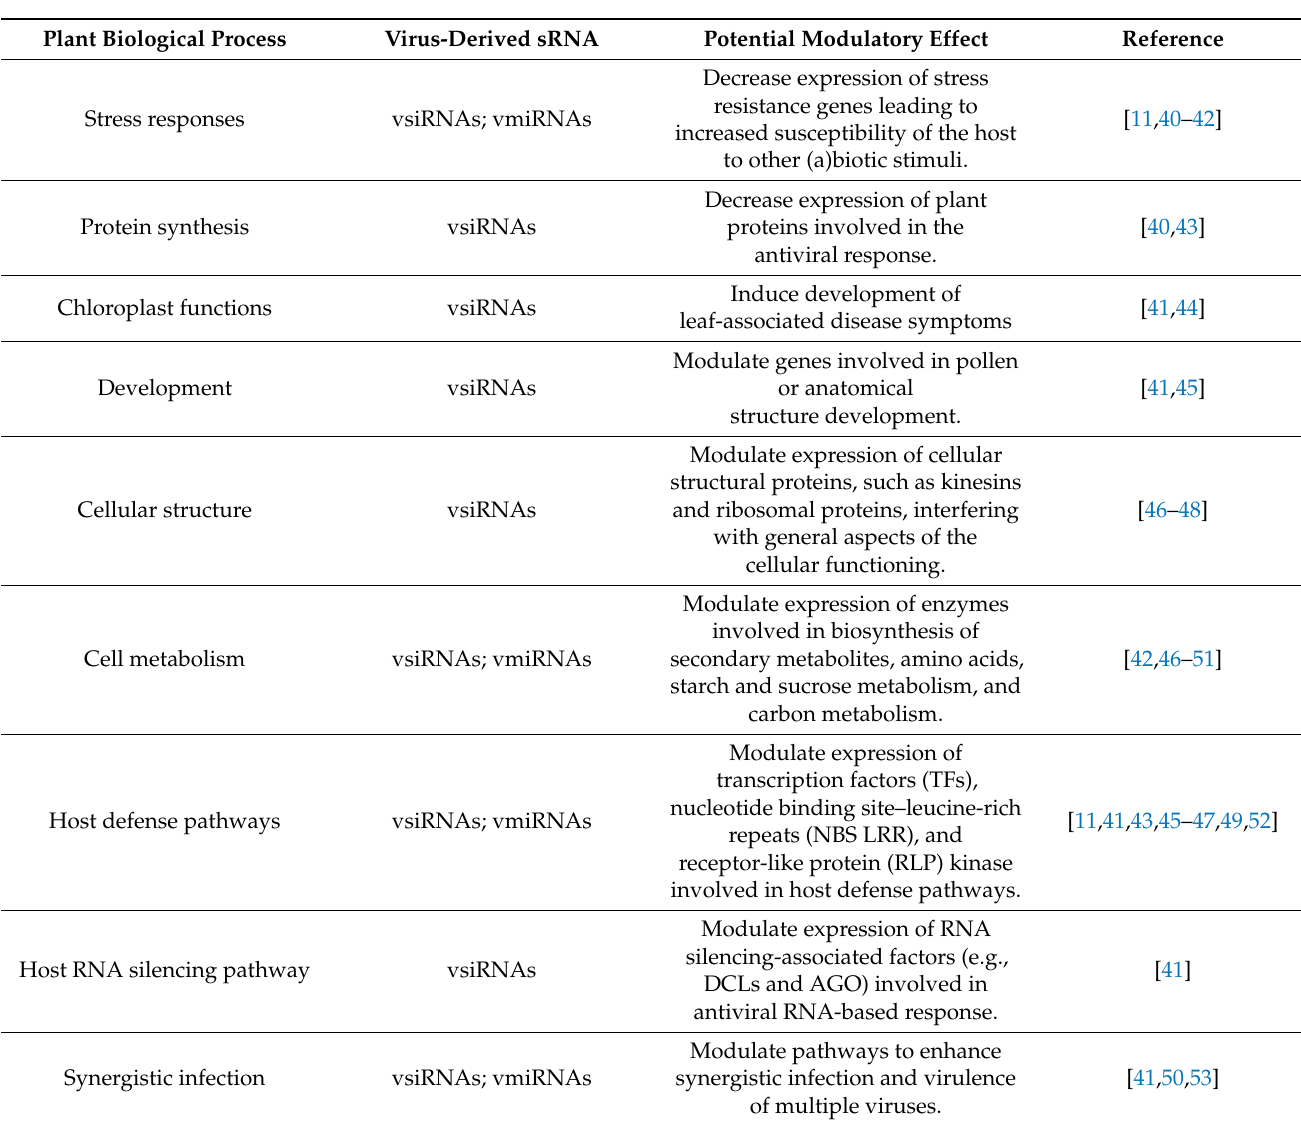
Table 2. Studies describing plant biological processes potentially and mostly affected by virus-derived sRNA-mediated gene